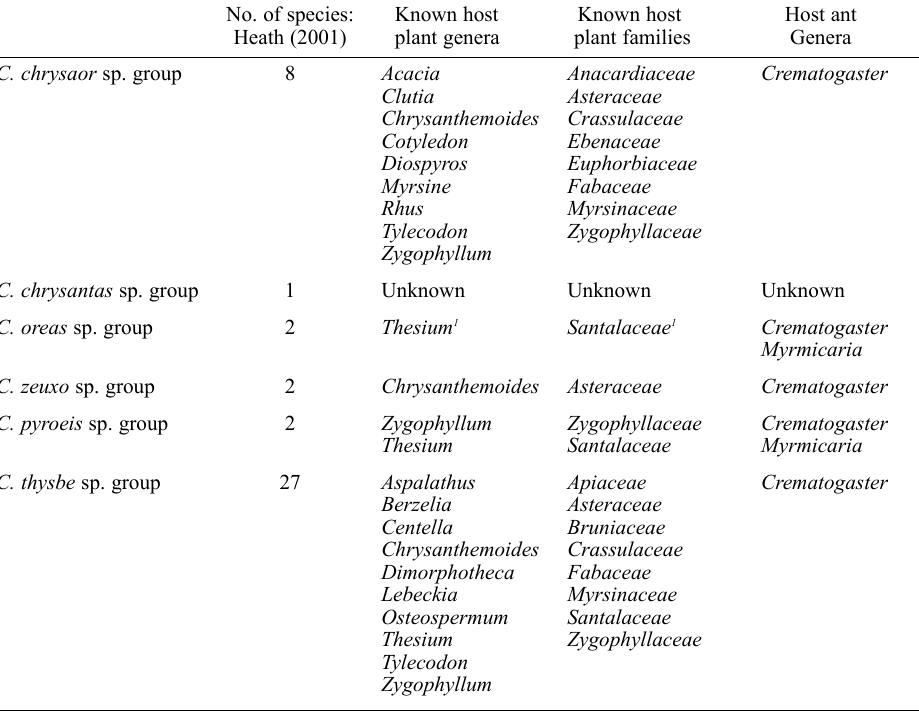
Table 2 Summary of the host plant genera, host plant families and attendant ant genera associated with the different species groups of Chrysoritis . The literature sources: Dickson (1940, 1943, 1944, 1945a, 1945b, 1946, 1947, 1948, 1953, 1959, 1965), Clark & Dickson (1971), Dickson & Kroon (1978), S.F. Henning (1983a), Owen-Johnston (1991), Heath & Brinkman (1995), Heath (1997a), Heath (1998), Claassens (2000) and Heath (2001). Plant genera and families are in alphabetic